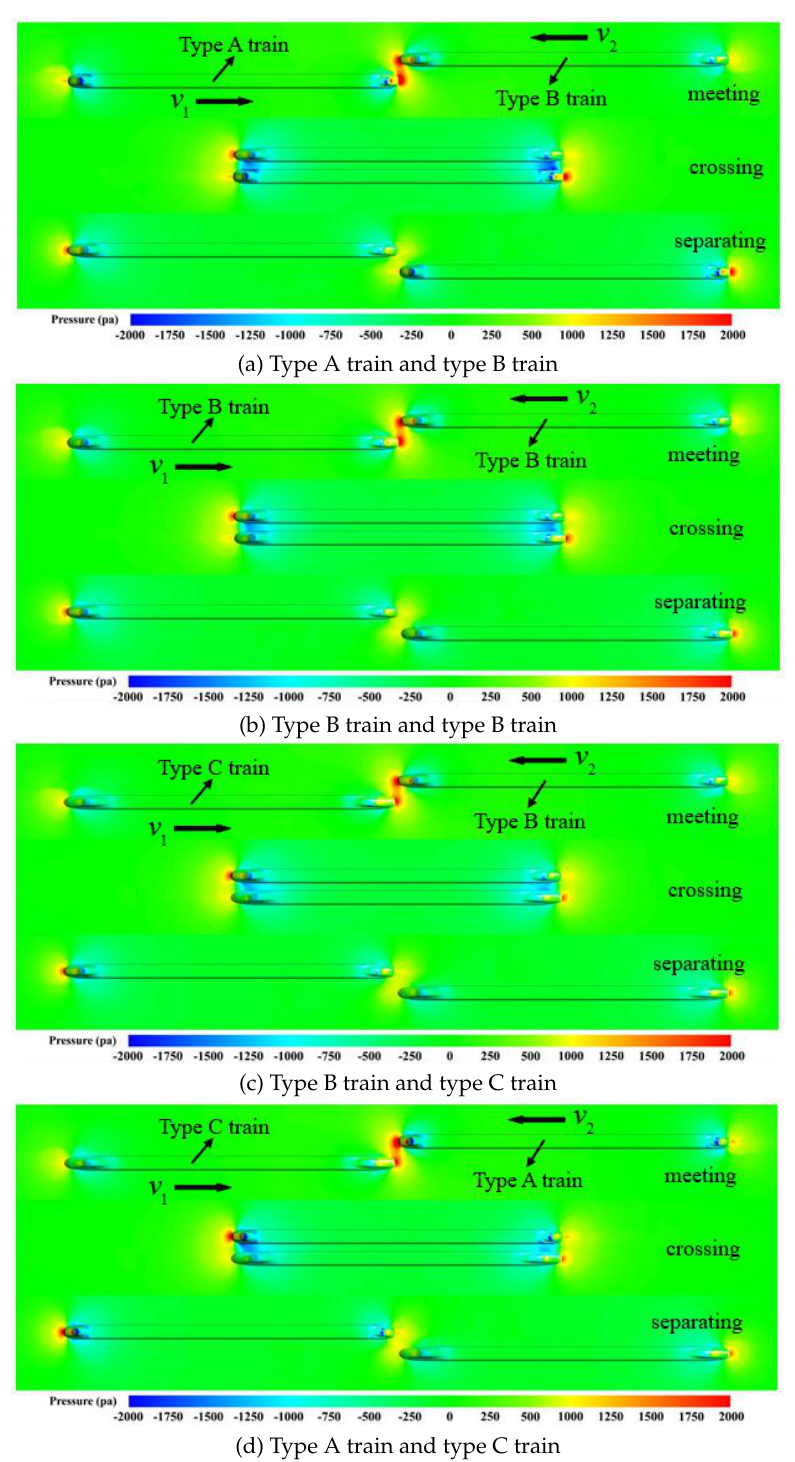
Fig. 7. Pressure distribution around the trains at different times